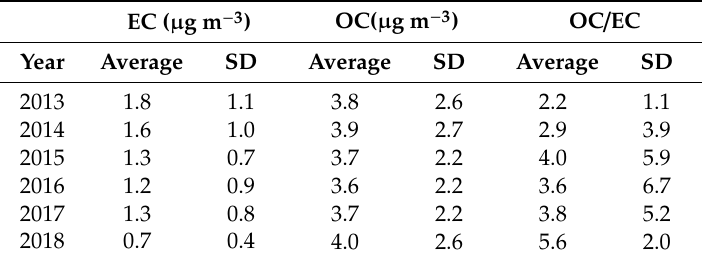
Table 4. Average organic carbon (OC) and elemental carbon (EC) concentration with OC / EC ratios in